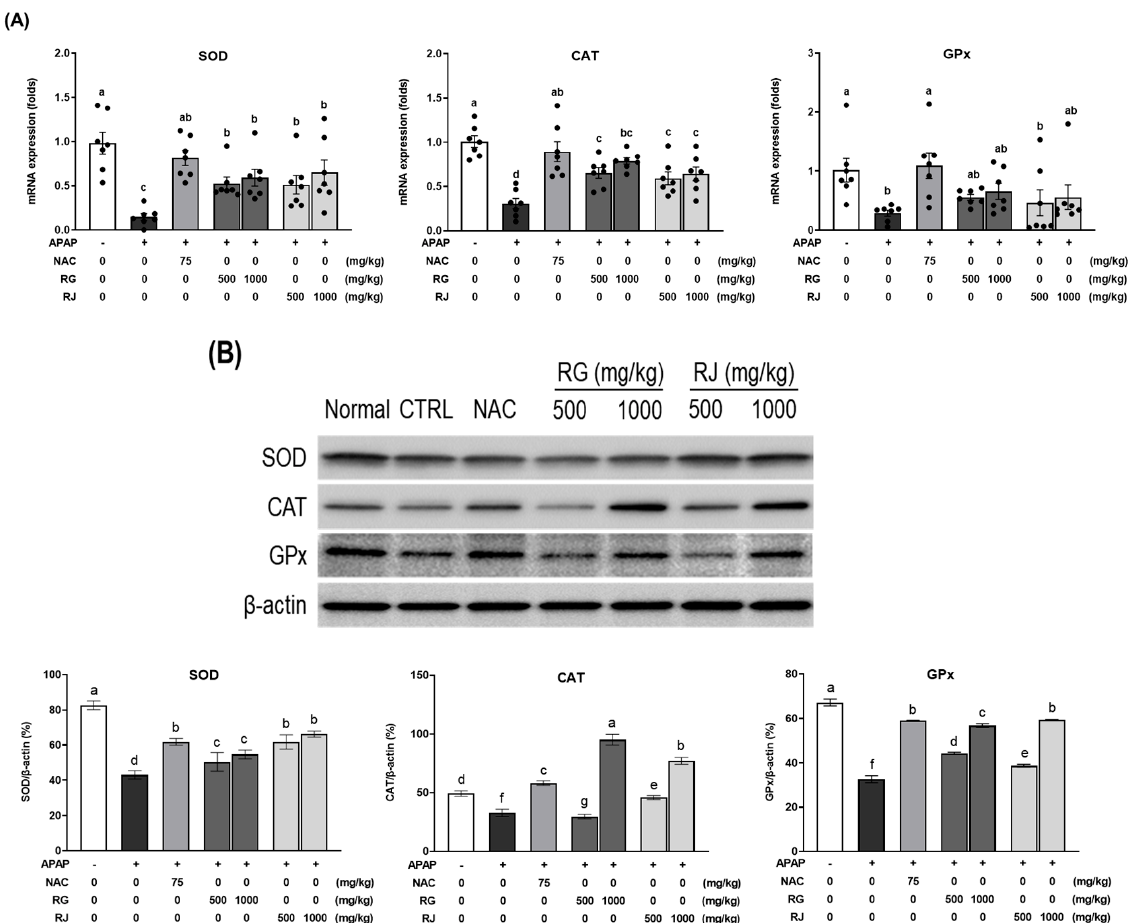
Figure 6. Effects of radish extracts on the mRNA and protein expression of antioxidant enzymes in APAP-induced mice liver tissue. ( A ) mRNA and ( B ) protein expression levels of superoxide dismutase (SOD), catalase (CAT), and glutathione peroxidase (GPx). Results are presented as the means ± SE. Different letters represent groups that are significantly different from each other using ANOVA at p < 0.05 ( n = 7). Each dot indicates data measurement for one mouse. CTRL, control; NAC, N-acetyl cysteine; RG, turnips of Ganghwa; RJ, radishes of Jeju.